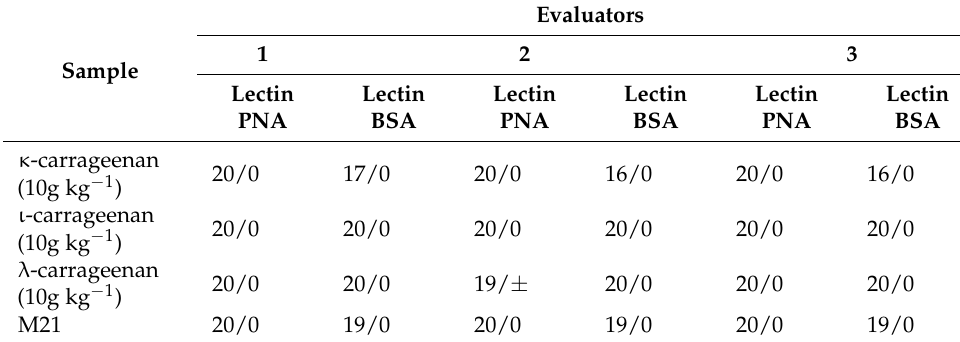
Table 2. Results of method